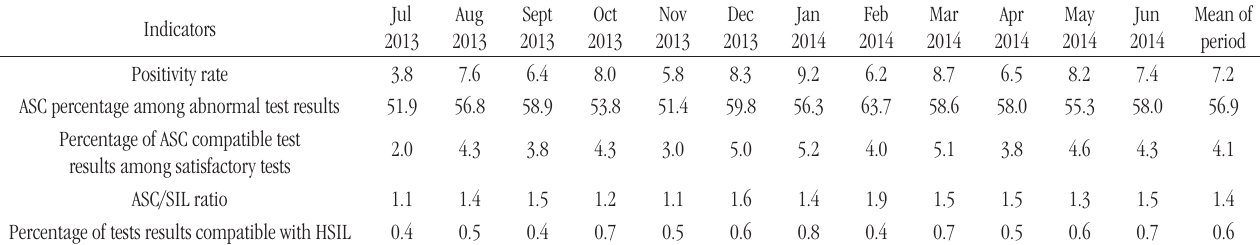
taBLE 1 − Quality Indicators from SITEC/INCA during the period from July 2013 to June 2014 Indicators